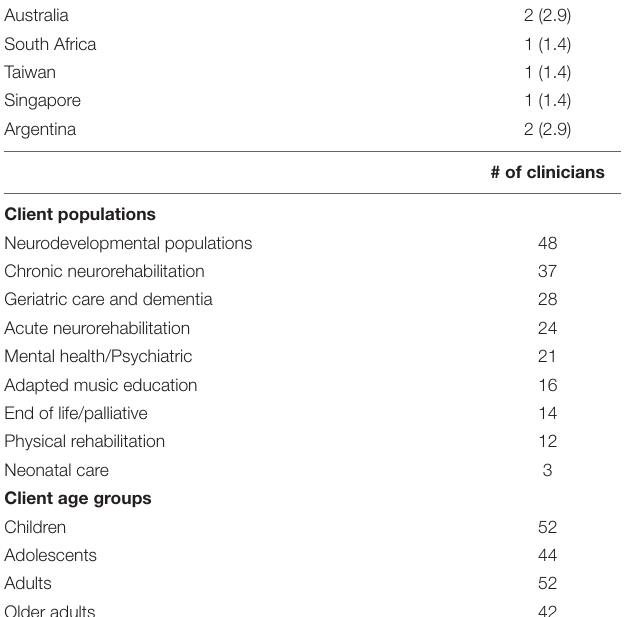
Table 4 indicates the correlations between six variables.